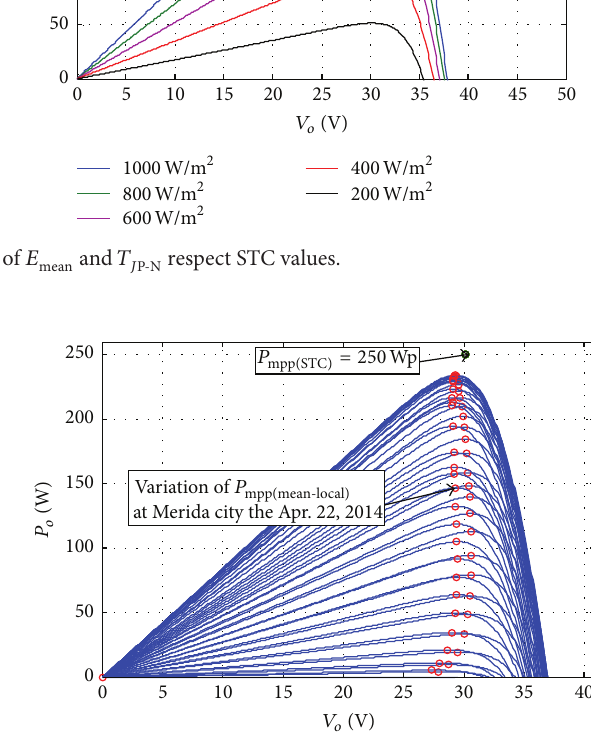
Figure 11: Simulation of 𝑃 mpp at Merida for all of one day. and location, 𝑃 mpp did not reach the value of 𝑃 mpp ( STC ) . This is the relevance to work with